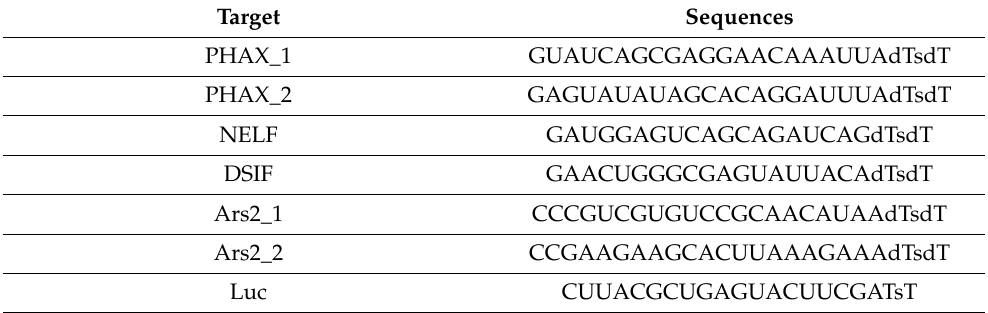
Figure A1. The quality of cellular extract separation was confirmed by RNA and protein analysis. ( A ) The RNA purified from the nuclear (NE) and cytoplasmic (CE) fractions of HEK293T cells was subjected to RT-qPCR to determine the amount of unspliced GAPDH (preGAPDH) and spliced GAPDH transcripts and U6 snRNA. ( B ) The total cellular protein (T) and proteins extracted from the CE and NE fractions were analyzed by Western blotting with the specified antibodies. Table A1. siRNAs used in this